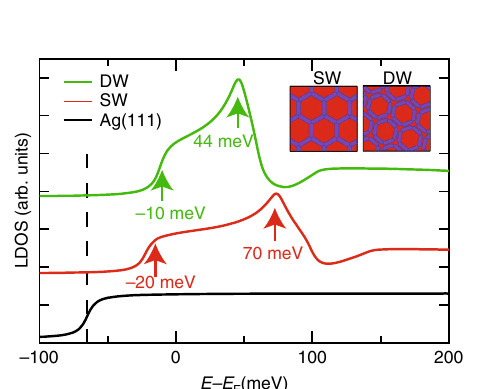
Fig. 4 EBEM simulations of the local electronic structure. Calculated d I /d V spectra, obtained after fi tting the experimental data with EBEM. The ARPES fi t was shifted by 100 meV for direct comparison with the d I /d V spectra in Fig. 2a. Insets show both molecular geometries used in EBEM calculations that closely match the STM topographies (Fig. 1e, f) and DFT calculated electric fi eld pro fi les (Supplementary Fig.